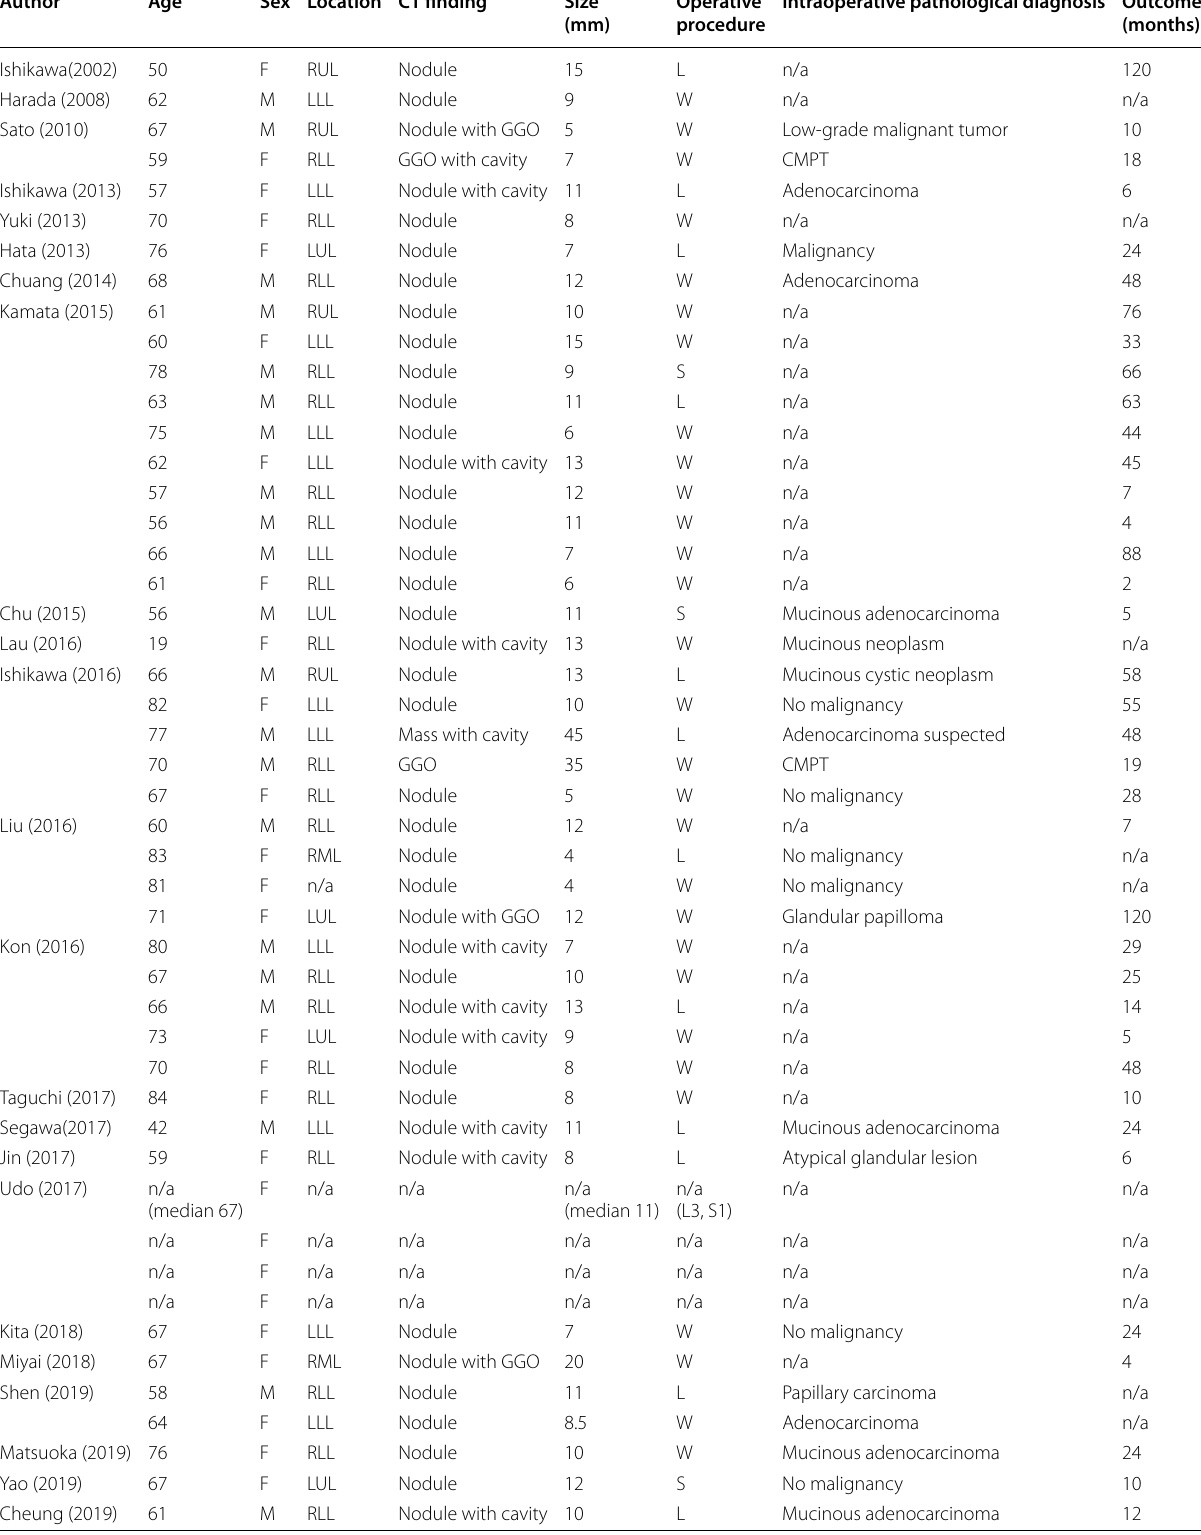
Table 1 Clinical features of reported CMPT